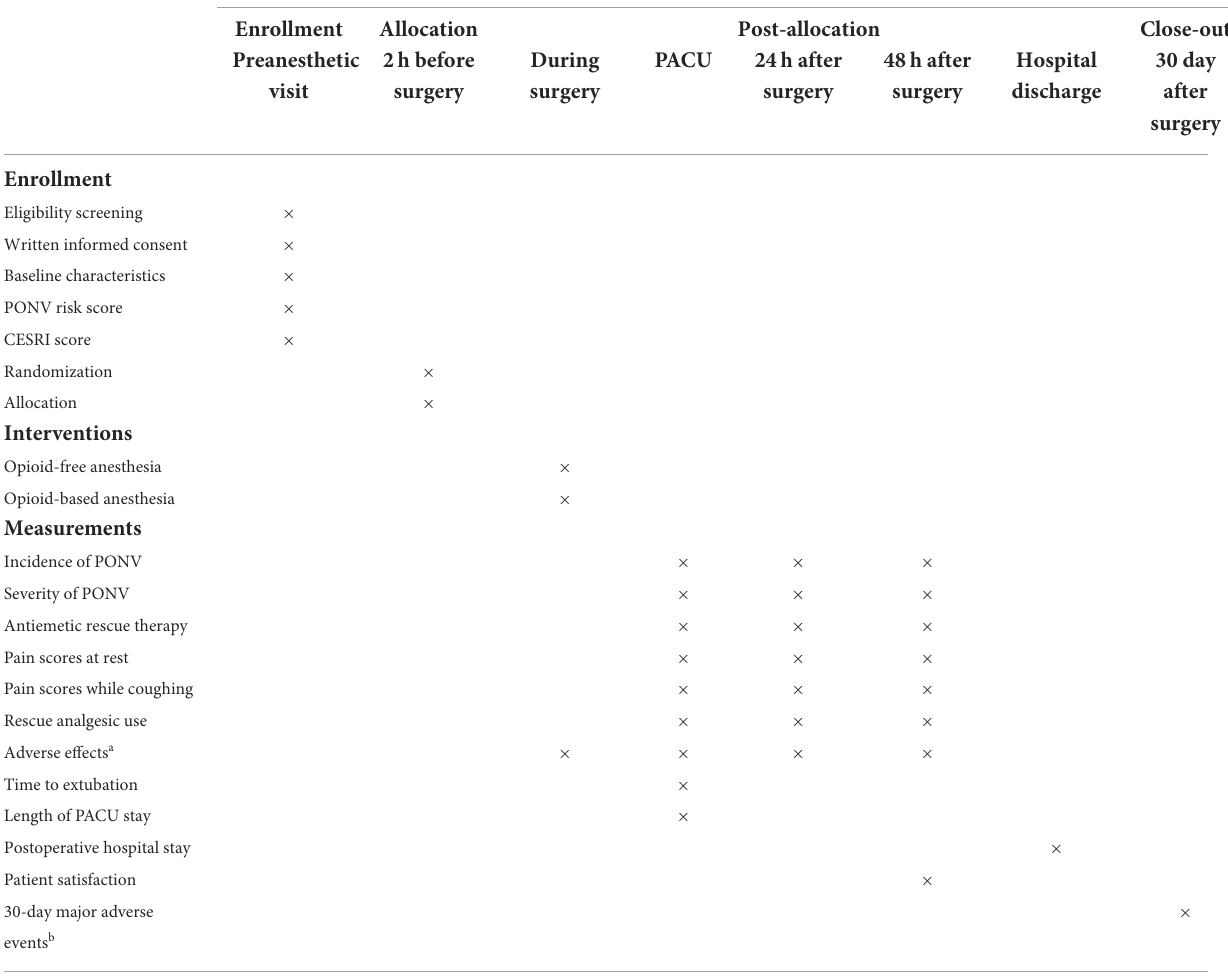
TABLE 1 Schedule of patient enrollment, study interventions, and outcome measurements. Timepoint Study period